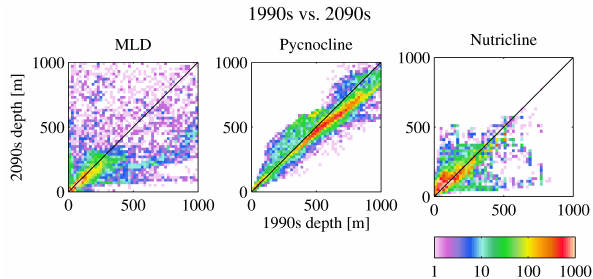
Fig. 10. Intercomparison of annual average 1990s ( x axis) and 2090s ( y axis) mixed layer depth (left), pycnocline depth (middle) and nutricline depth (right). Color represents the density of model grid cells, on a logarithmic scale. The black diagonal line in each panel denotes the 1 : 1 relationship between plotted fields.